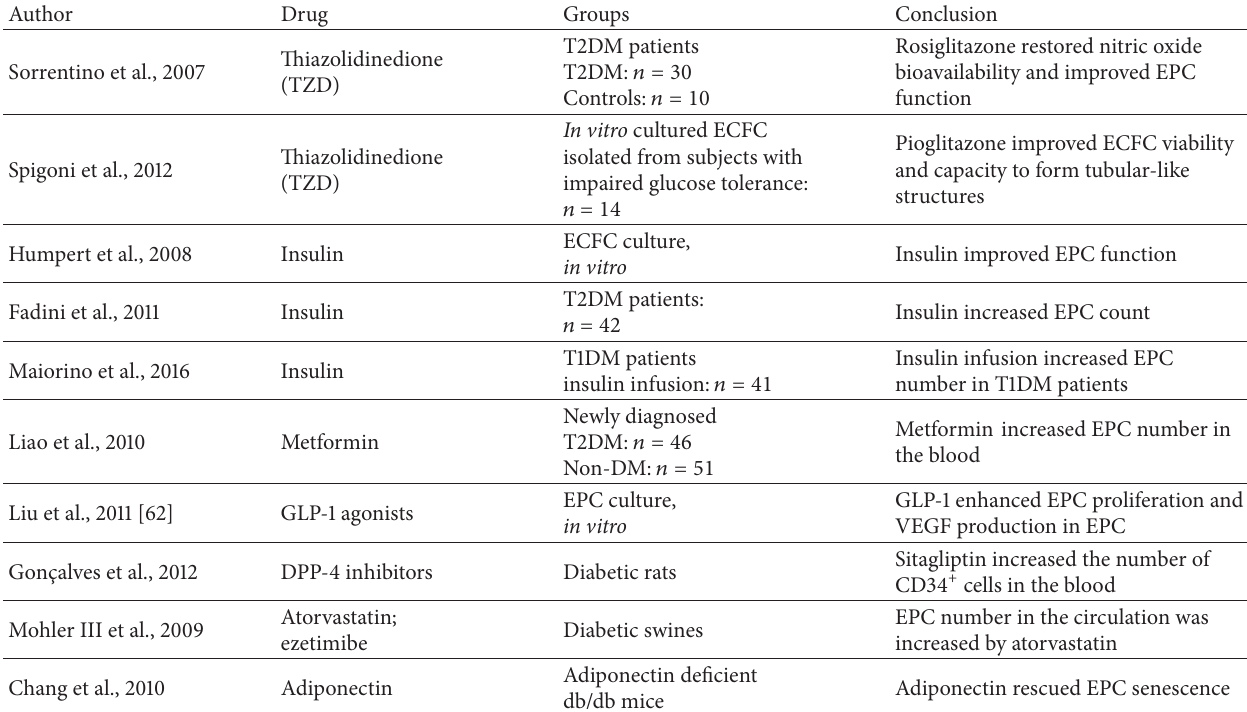
Table 1: Overview of the effect of antidiabetic drugs on EPCs number and